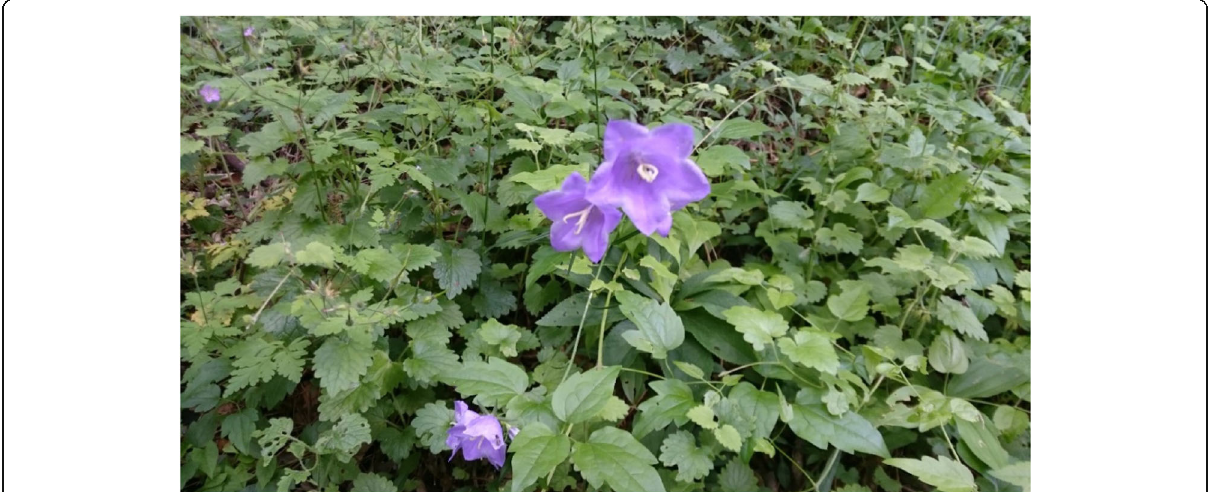
Fig. 6 Bell flower ( Campanula persicifolia L.) at Avala site, Belgrade,